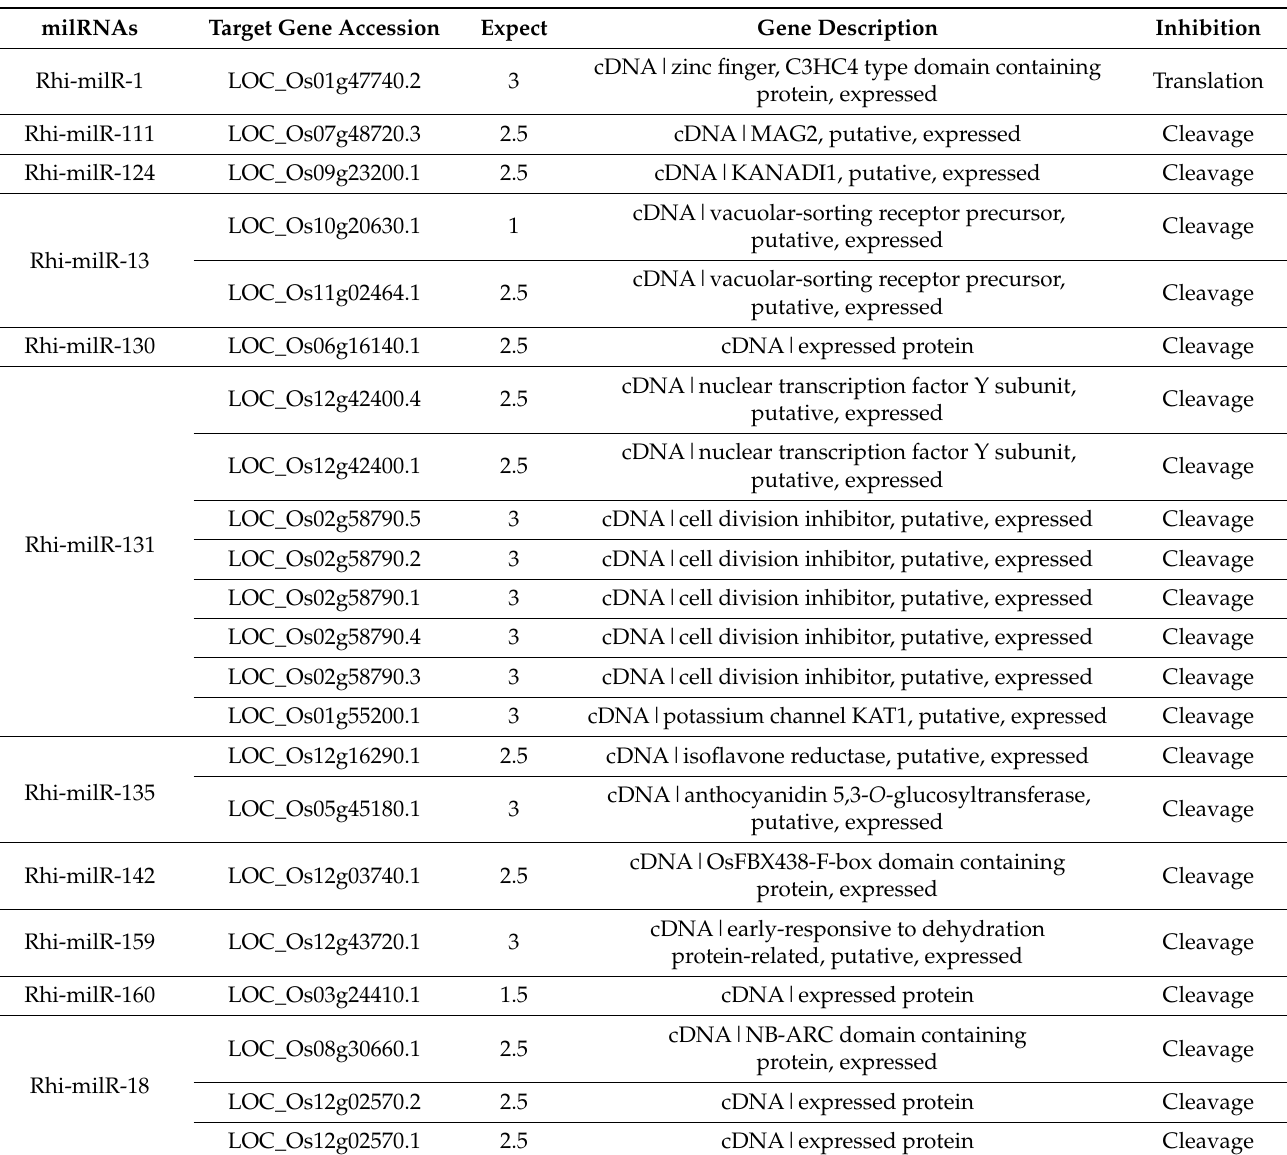
Table 4. Target genes of Rhizoctonia solani milRNAs in rice genome; 24 milRNAs showed their target as rice genes encoding proteins associated with defense and other metabolic